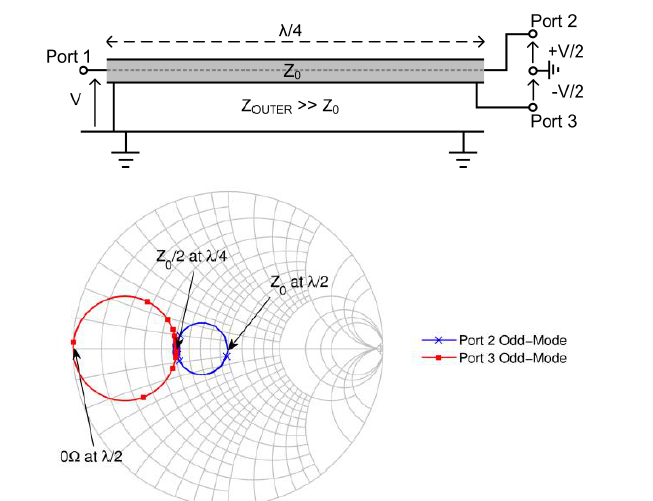
Fig. 7. Signal division / addition scheme based on the λ / 4 coaxial line and Smith diagram of the simulation results of the circuit